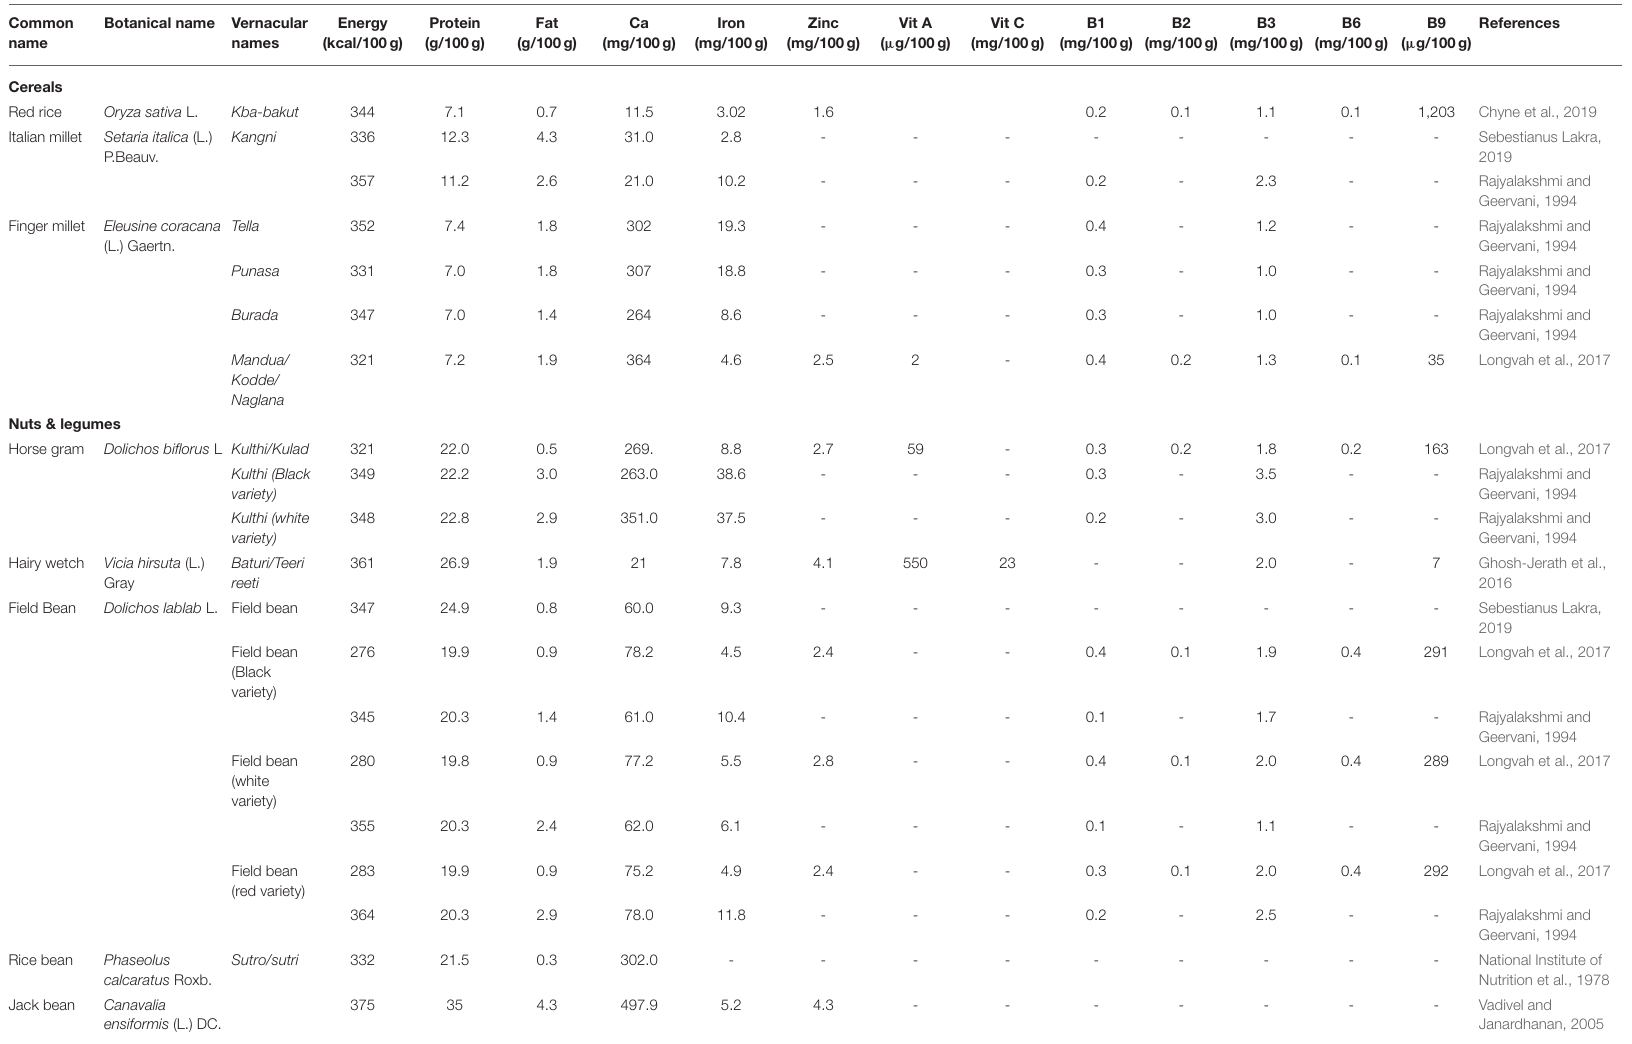
TABLE 1 | Nutritive values of selected indigenous foods of India ( n = 69).